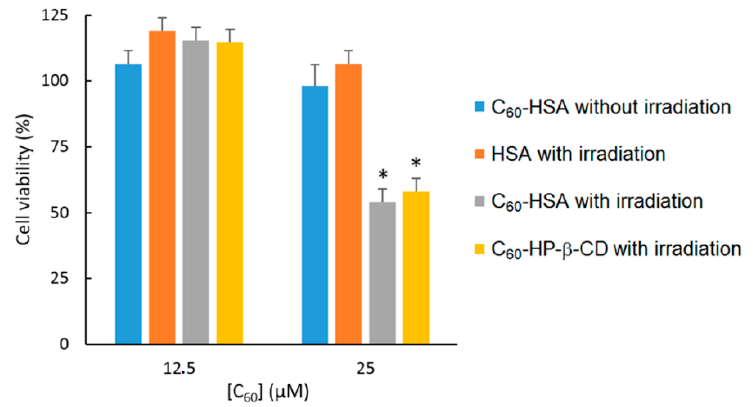
Figure 70. PDT activity of human serum albumin (HSA) solution alone, HSA-C 60 solution, and C 60 -HP- β -CD NPs on A549 cells in the dark or after irradiation ( λ = 400-700 nm, 35 mW/cm 2 for 30 min). Each point represents the mean ± SE of five experiments. * p < 0.05 vs. HAS alone solution. Adapted from Altaf; Aldawsari; Banjar; Makoto; Daisuke; Masaki; Kaneto; Fumitoshi [219].